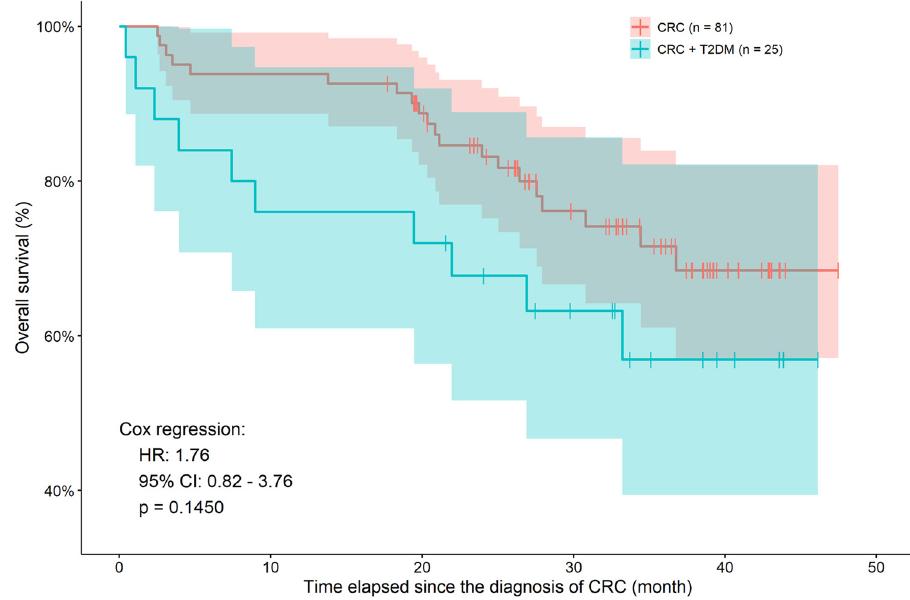
Figure 3: Naïve Kaplan – Meier curves of CRC patients with and without T2DM. It should be noted that although the two curves do not appear to be similar, neither Cox regression ( p = 0.1450 ) , nor log - rank test ( p = 0.0908 ) could justify a statistical di ff